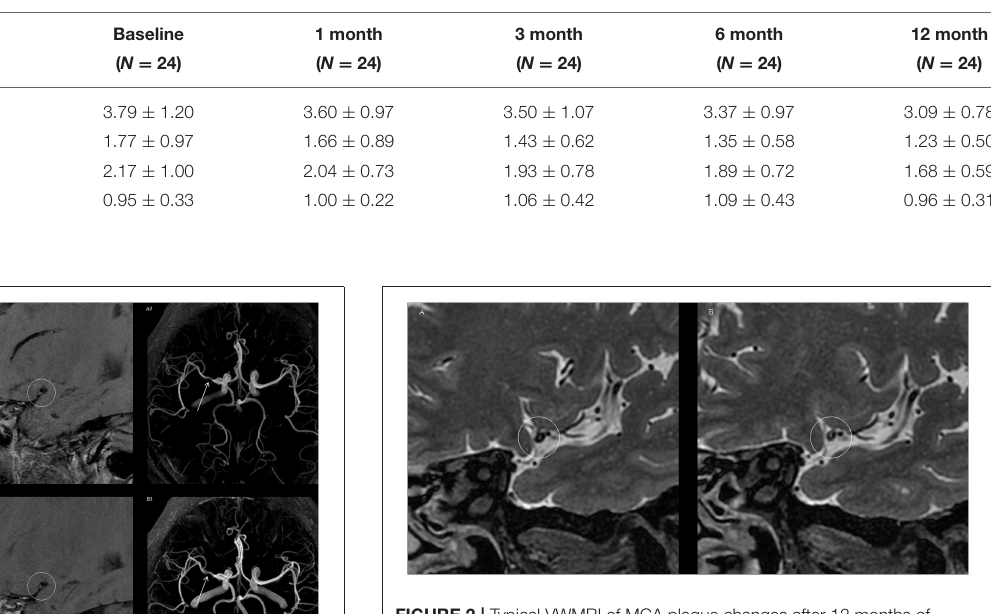
FIGURE 2 | Typical VWMRI of MCA plaque changes after 12 months of atorvastatin treatment in a patient. (A) At baseline, the MCA plaques have a large lipid core with a thin fibrous cap and poorly displayed fibrous cap edges. (B) MCA plaque volume reduction at the 12-month follow-up time point. The image depicts plaque lipid core volume reduction, accompanied by fiber cap thickening, with the fiber cap edge showing more clearly.